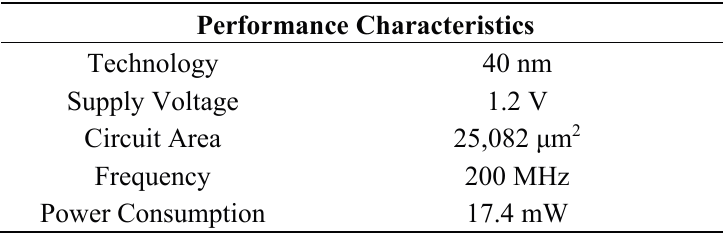
Table 3. Performance characteristics of the IC synthesis simulation for the proposed de-noising system